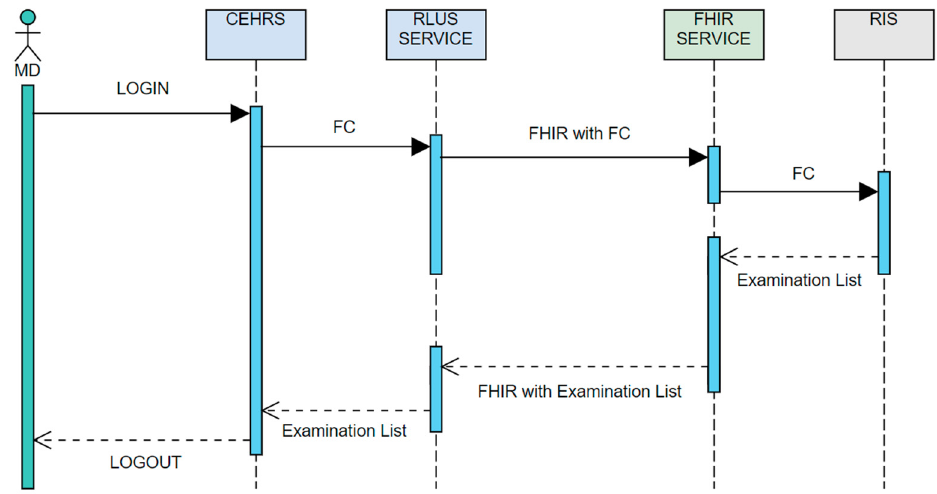
Figure 7. Pathway for search and retrieval of the diagnostic report list.